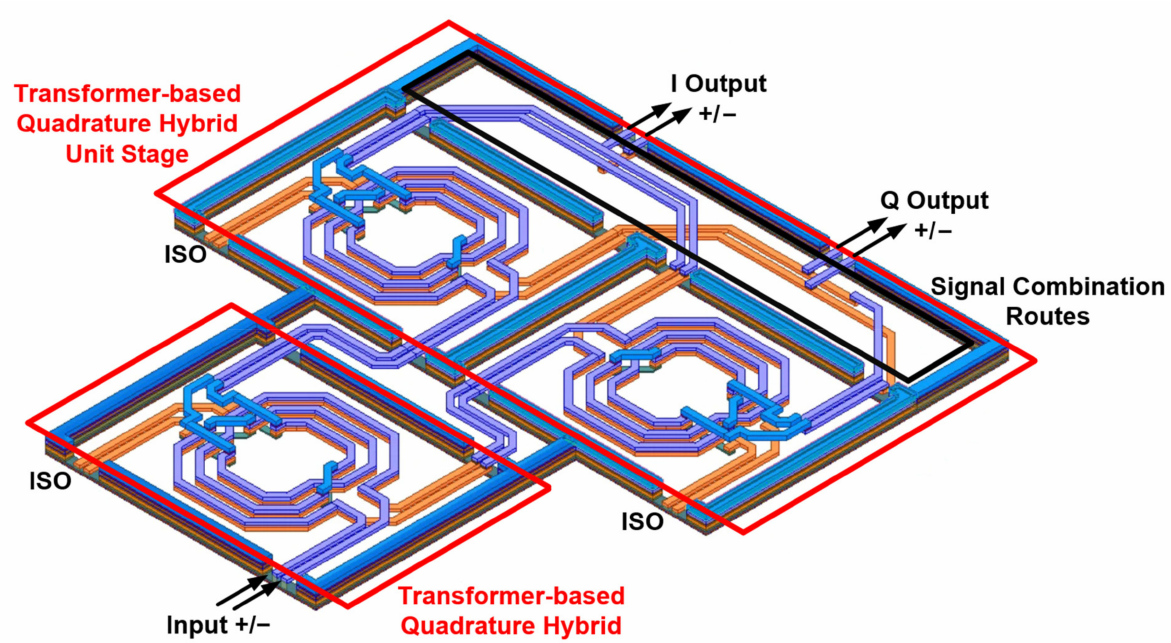
Figure 9. 3D EM model of the proposed cascaded transformer-based quadrature